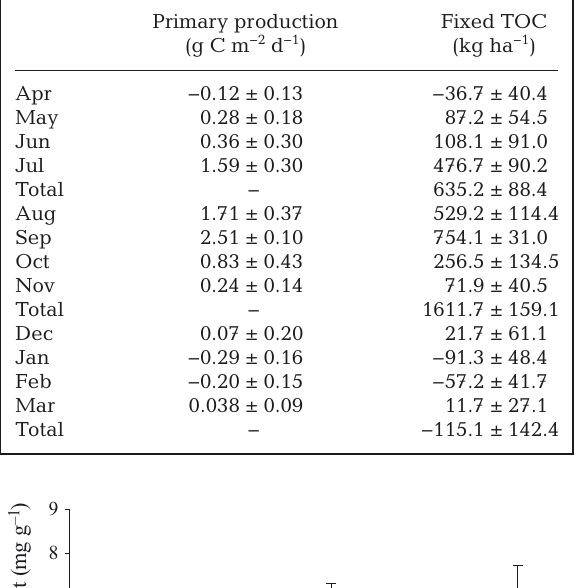
Table 2. Monthly variations of primary production (mean ± SD, n = 3) and the fixed total organic carbon (TOC) by pri- mary production in polyculture seawater ponds (PSPs) with- out feeding. Carbon fixed by net primary production was evaluated as the difference between the carbon fixed by gross primary production and the carbon consumption by